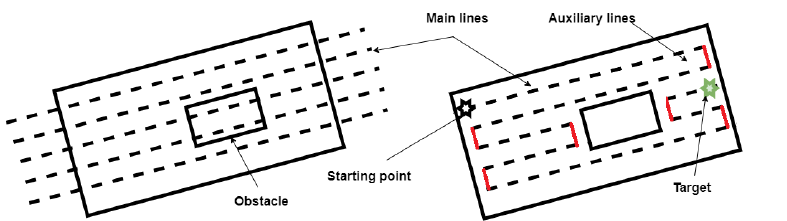
Figure 2. The map with both main lines (black) and auxiliary lines (red).